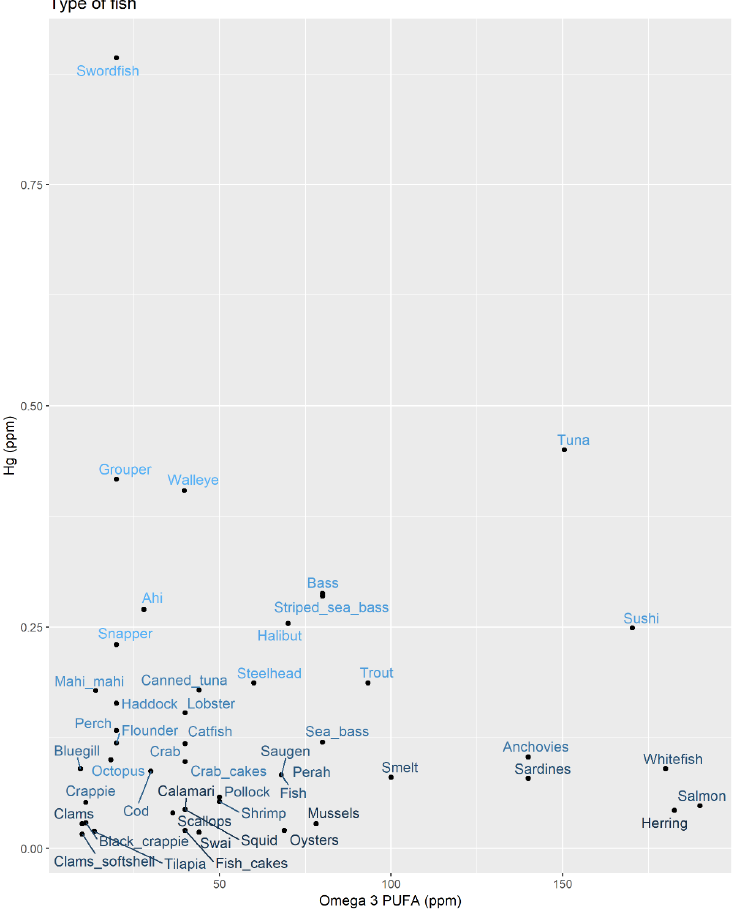
Figure 2. Mean mercury and omega-3 polyunsaturated fatty acid (PUFA) concentrations in seafood consumed by study participants. (brighter blue indicates higher mercury levels).